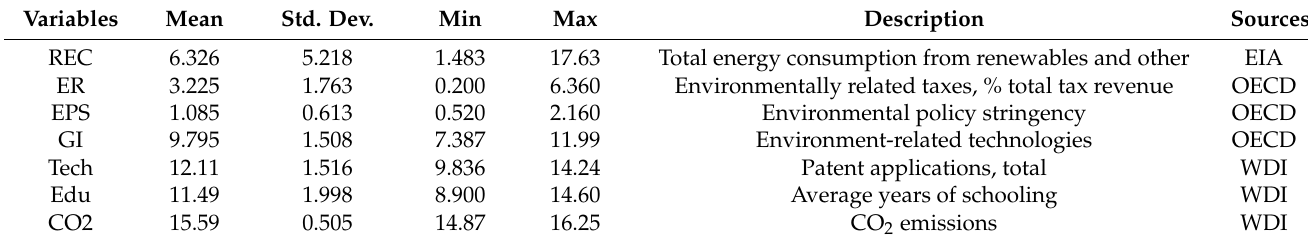
Table 1. Data description.